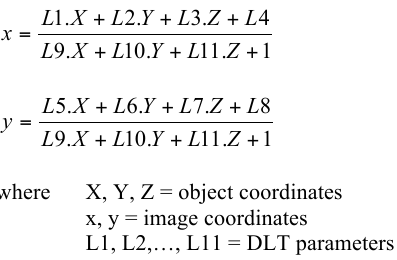
Figure 7. Unwrapping of a cylindrical surface: (a) colorized point cloud of the surface; (b) photographs; (c) mosaic of